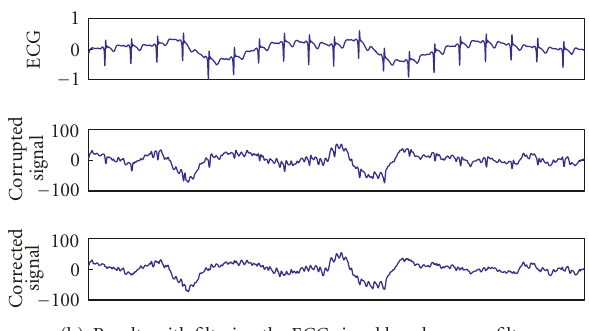
(b) Results with filtering the ECG signal by a low-pass filter Figure 15: AF-ECG correction of the cardiac artifact in the presence of a slow wave on the ECG: (a) results without filtering the ECG by a low-pass filter, (b) result with filtering the ECG by a low-pass filter.